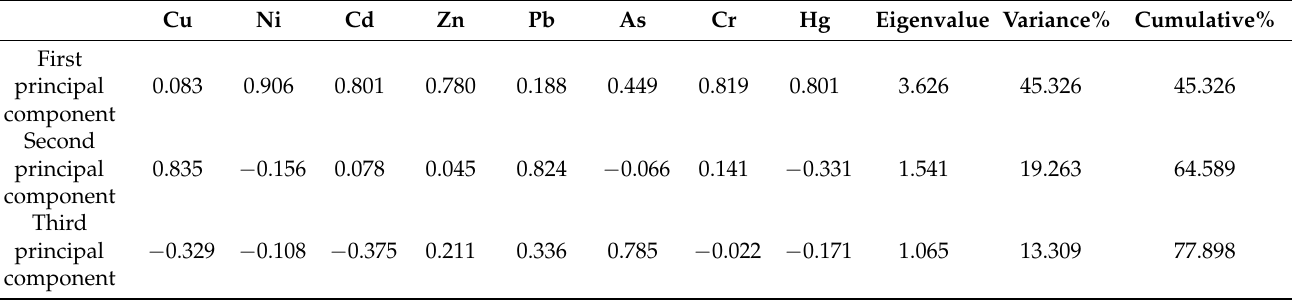
Table 6. Principal component analysis of heavy metals in